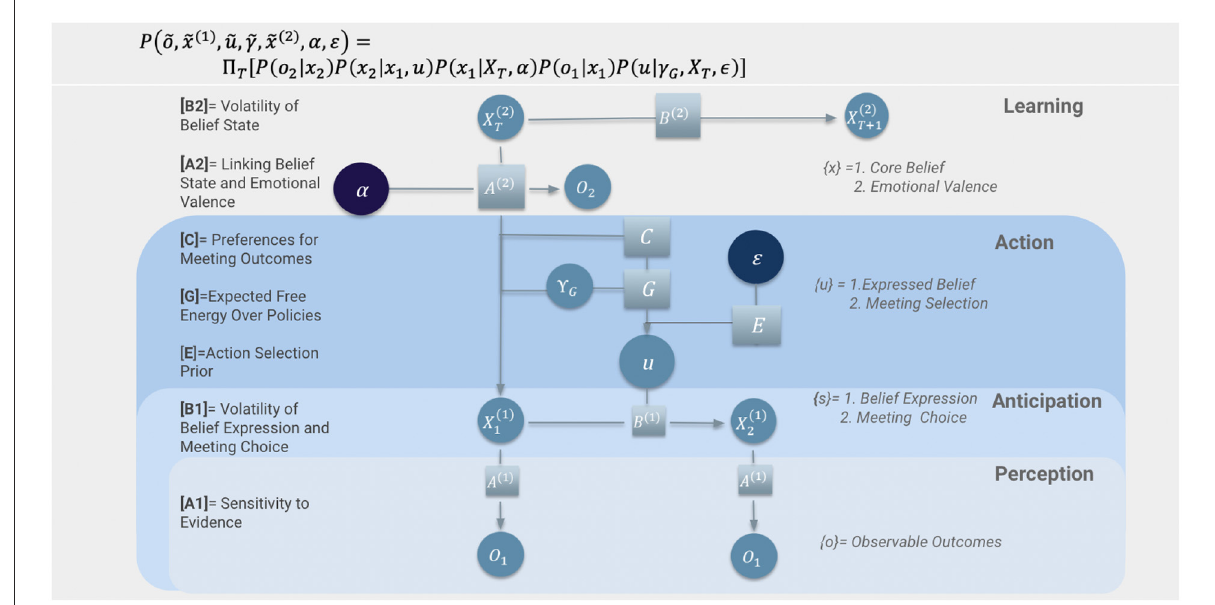
FIGURE2 A generative model of communication. This Figure was reprinted from an open-source preprint of a conference paper, with permission of the authors (Figure 1 of Kastel and Hesp, 2021). Variables are depicted as circles, parameters as squares and concentration parameters as dark blue circles. Visualized on a horizontal line from left to right, states evolve in time. Visualized on a vertical line from bottom to top, parameters underwrite a hierarchical structure that corresponds to levels of cognitive processing. Parameters are listed on the left of the generative model and variables are on the